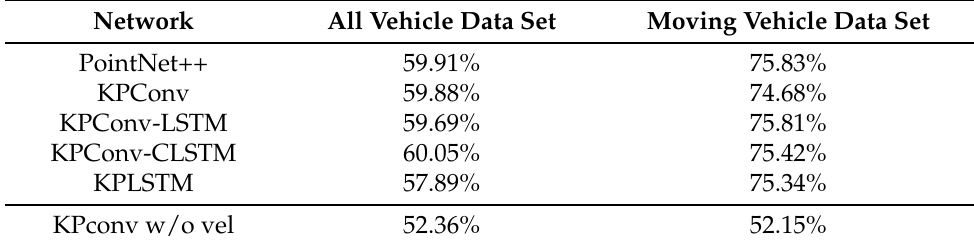
Table 1. Segmentation macro-averaged F1-scores on the nuScenes validation data